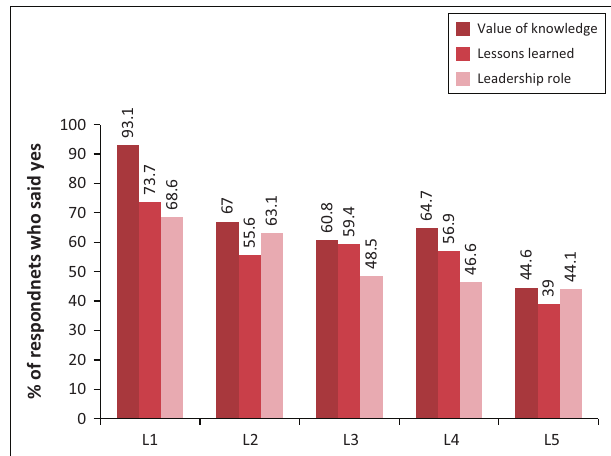
FIGURE 7: Summary of level of consensus of how the value of knowledge is